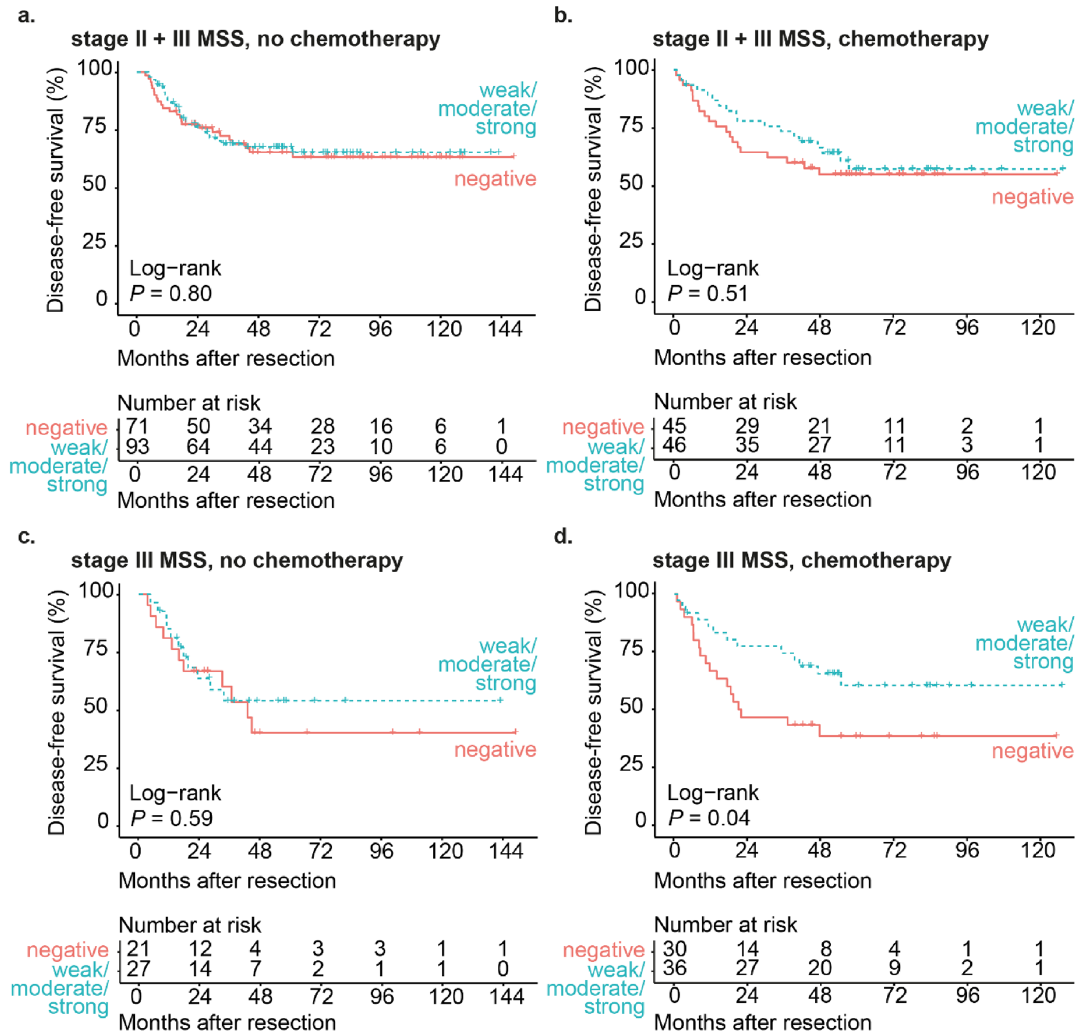
Figure 3. High SLPI expression in chemotherapy-treated stage III MSS CRC patients is associated with increased disease-free survival. Kaplan–Meier curves for disease-free survival after resection of the primary tumor (in months) for stage II and stage III CRC patients with MSS tumors not treated with adjuvant chemotherapy ( a ) or treated with adjuvant chemotherapy ( b ) stratified by SLPI expression detected using the monoclonal antibody. Kaplan–Meier curves for disease-free survival after resection of the primary tumor (in months) for stage III CRC patients with MSS tumors not treated with adjuvant chemotherapy ( c ) or treated with adjuvant chemotherapy ( d ) stratified by SLPI expression detected using the monoclonal antibody. Curves with the validated cut-off are shown. P -values were calculated using the log-rank test. MSS micro-satellite